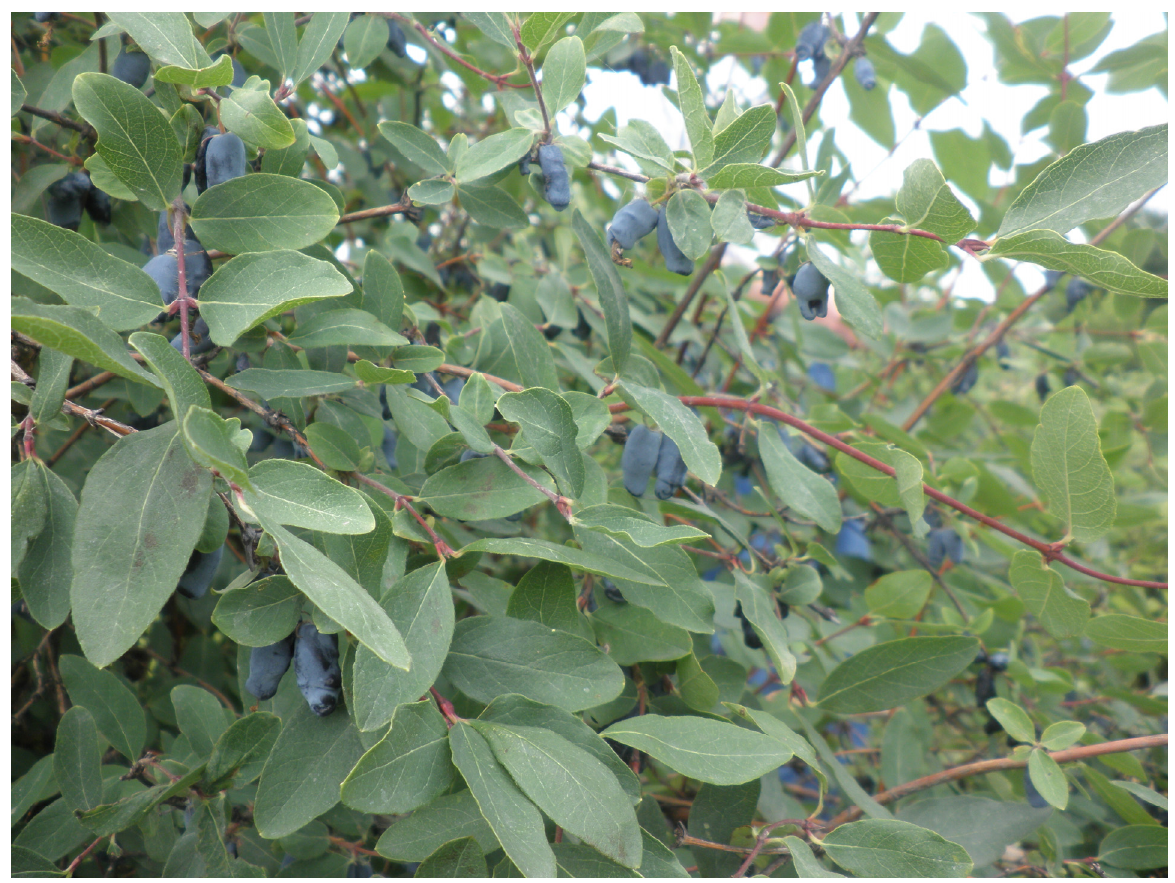
Figure 1. Lonicera edulis with fully ripened